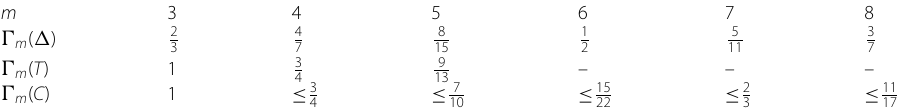
Table 1 Exact values of (cid:3) m ( (cid:7) ) (cf. [11, p. 333]) and (cid:3) m ( T ) (cf. [9, p. 2559]) and consequences of Theorem 4 for (cid:3) m ( C ) with C = T m